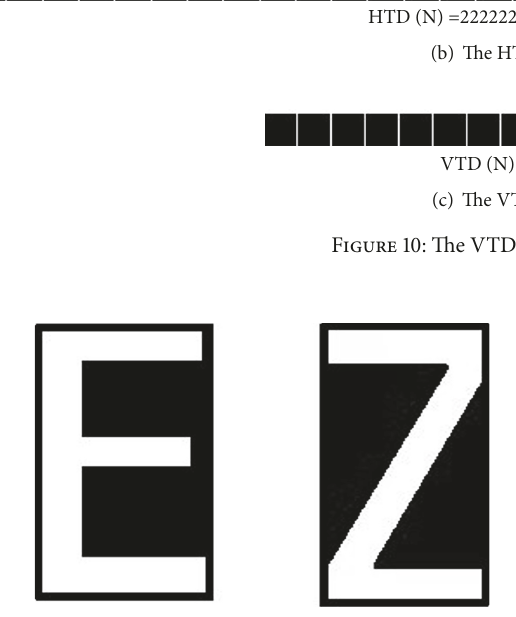
Figure 11: The character “E” and the character “Z”. Figure 12: The edge distance feature values extraction of the character